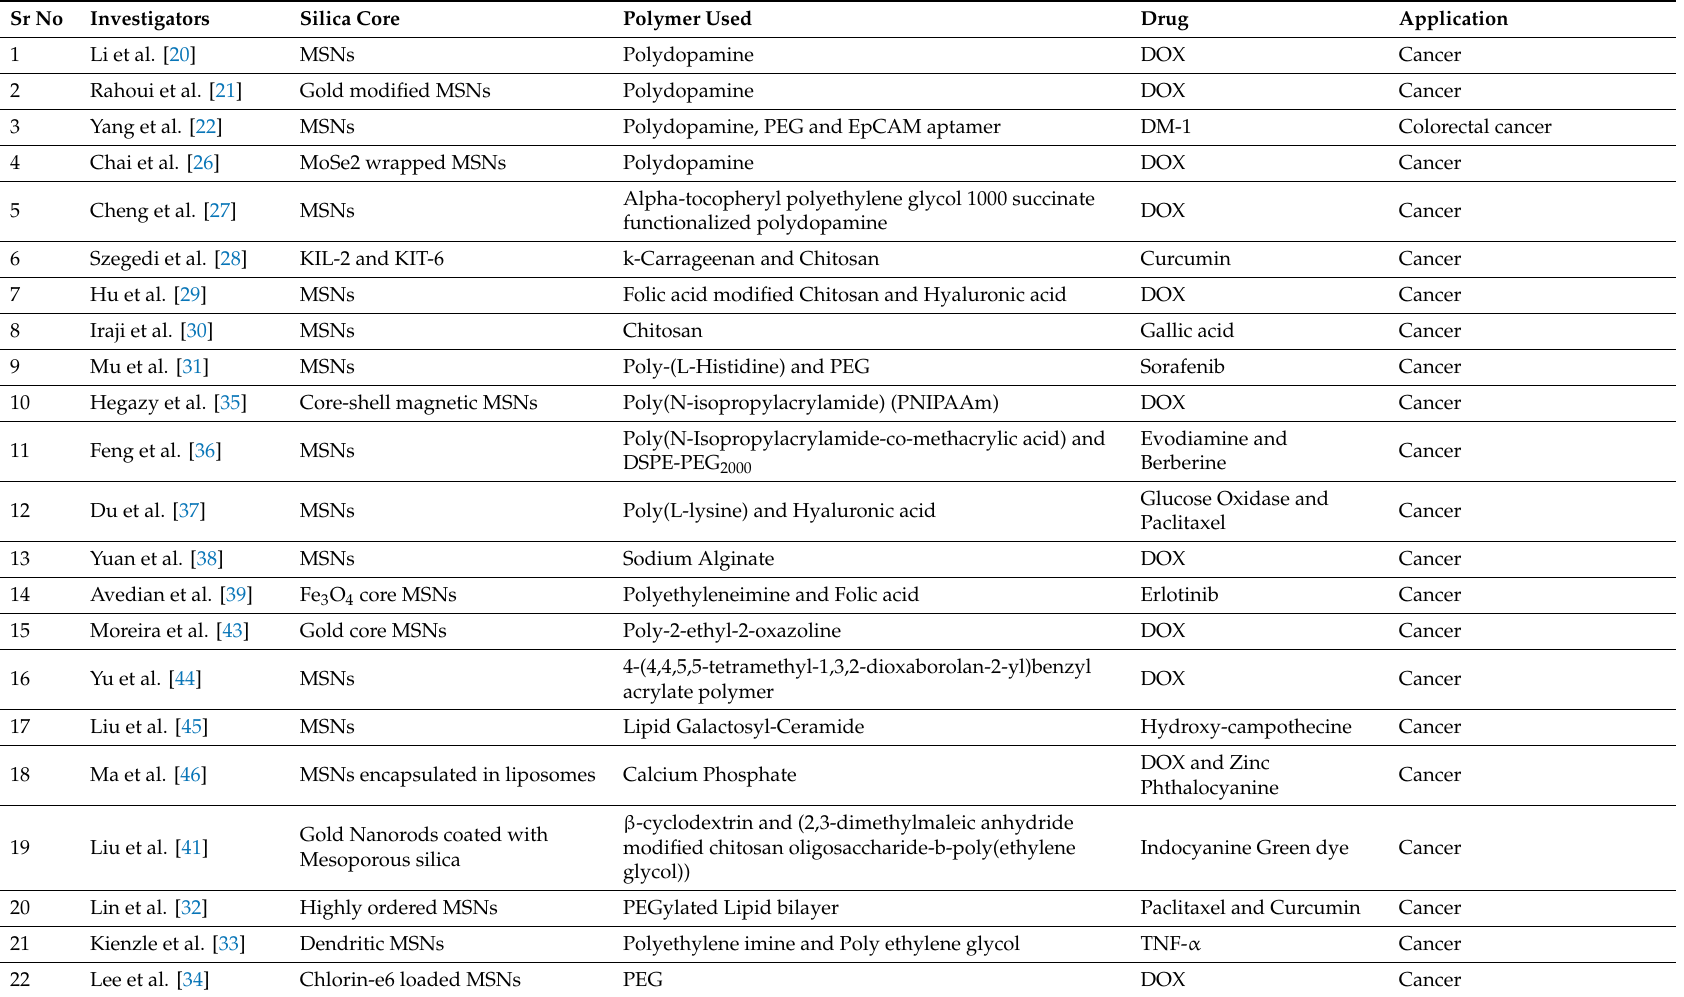
Table 2. Tabular presentation of di ff erent coating materials used for MSNs along with their investigated